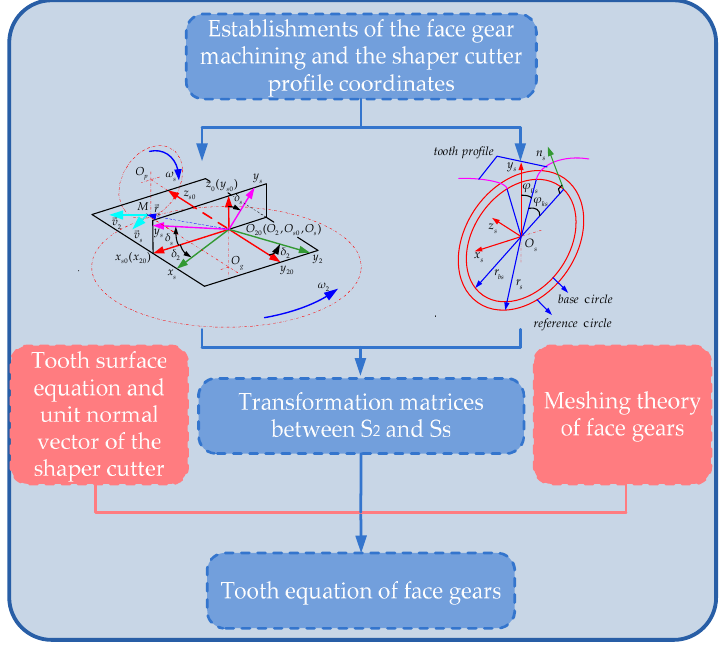
Figure 1. Flowchart of establishing face gear tooth surface equations.